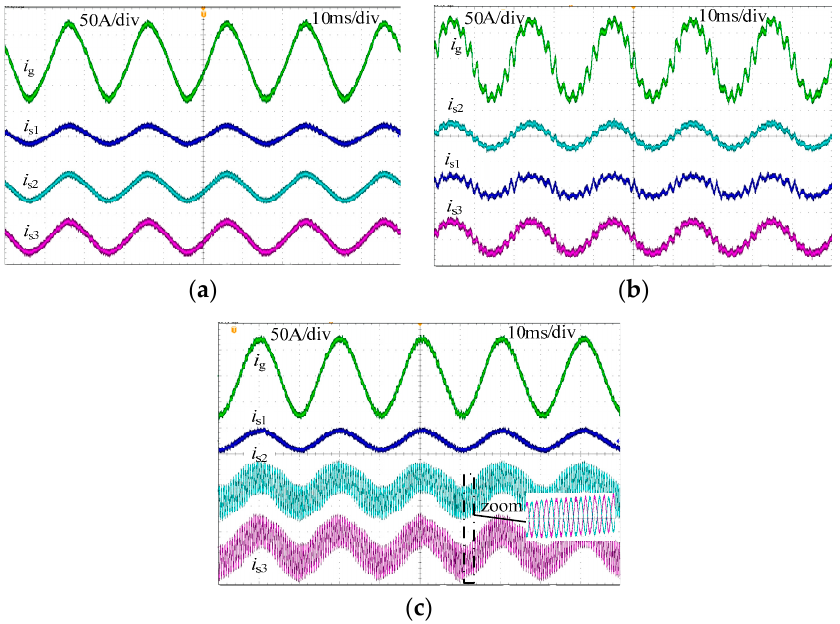
Figure 11. Experimental current waveforms of System I: ( a ) stat-A; ( b ) stat-B; ( c ) stat-C.